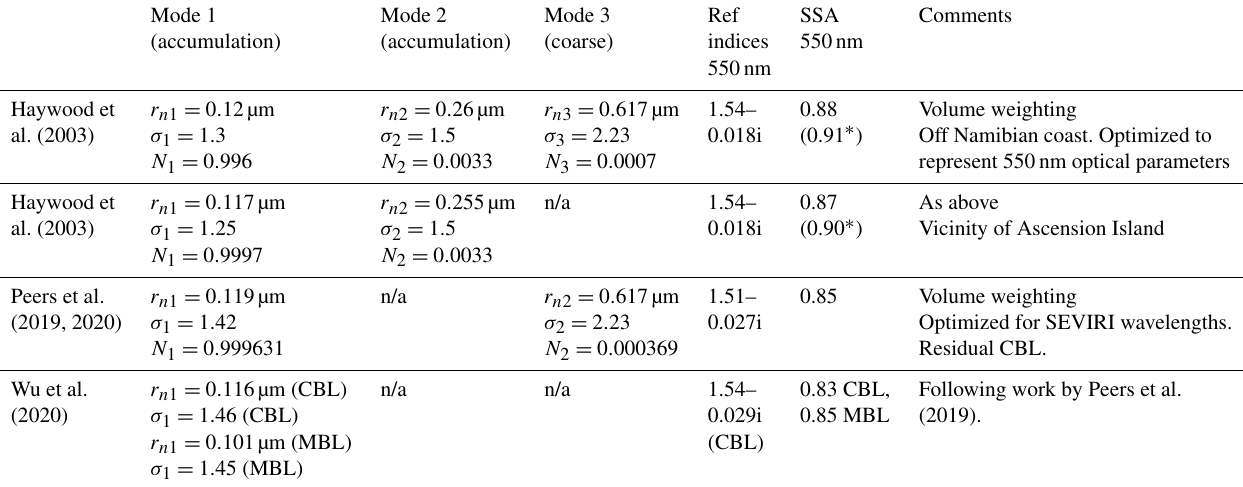
Table 3. Showing the models that have been fitted to aerosol size distributions. ∗ Originally a SSA at 550nm of 0.91 (Ascension Island) and 0.90 (off coast of Namibia) was reported for BBA, but this was reassessed using more rigorous corrections to absorption and scattering corrections to yield 0 . 88 / 0 . 87 by Johnson et al. (2008). N x represents the fractional number concentration in mode x . The refractive indices represent the effective refractive indices that combine with the size distribution and Mie scattering theory to yield the reported SSA. Mode 1 Mode 2 Mode 3 Ref